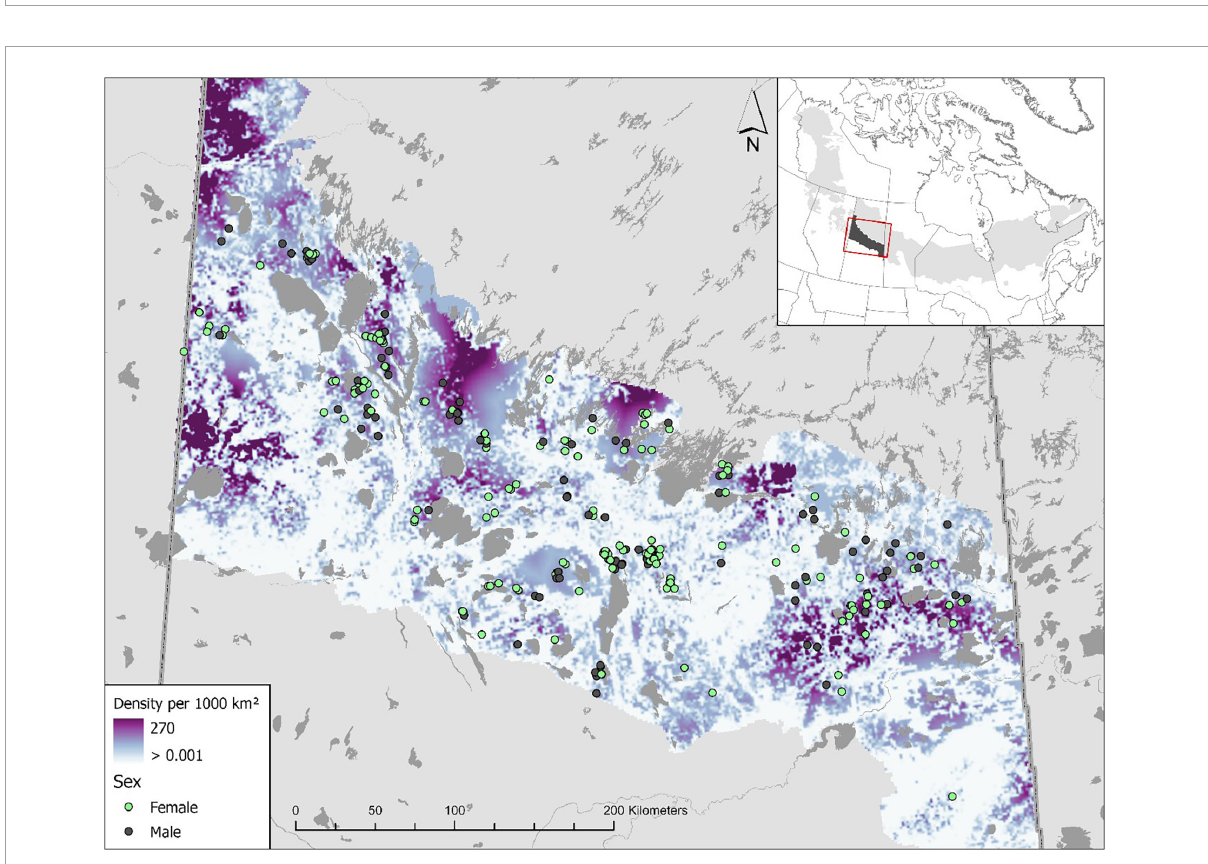
FIGURE3 Spatially explicit boreal caribou density across the Saskatchewan boreal plains caribou range. Boreal caribou density was associated with good- and poor-quality habitat and linear disturbances. Densities are overall low and spatially clustered, greatest away from linear features and poor-quality